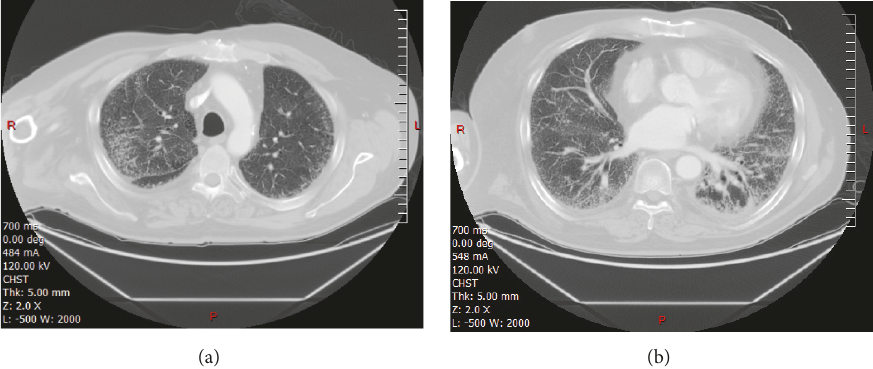
Figure 9: CT images 3 months after the initial presentation of pneumonitis. Images are at approximately the same level as those shown in Figure 6. There has been considerable clearing of the infiltrates and dense